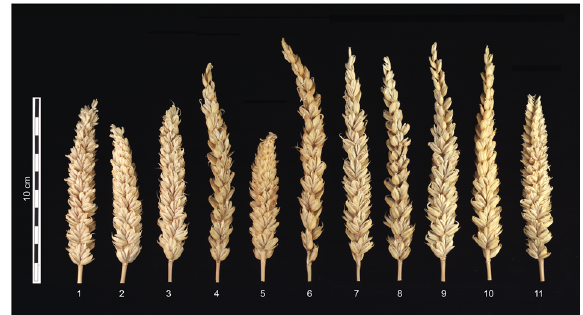
Fig. 1 Spike morphology in wheat lines. Lines: (1) CS, (2) N1D/T1A, (3) N1D/T1B, (4) Dt1DS, (5) Dt1DL. (6) 1DL-4. (7) 1DL-1. (8) 1DL-3. (9) 1DL-6. (10) 1DL-2, (11) CSDt1DSAL